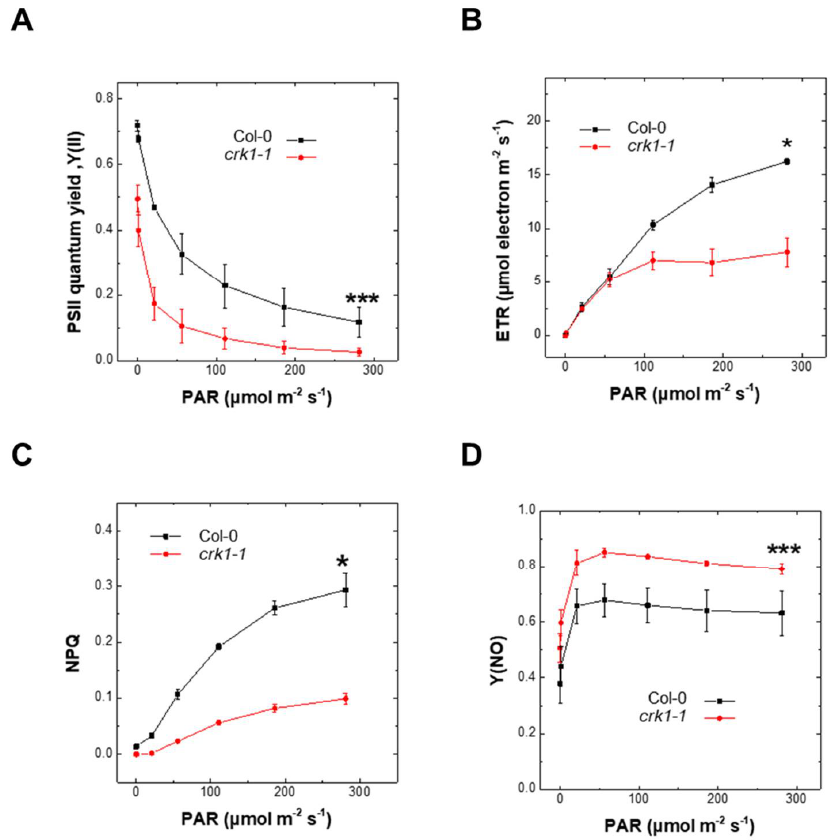
Figure 7. Photosynthetic parameters of At crk1-1 mutant under continuous light. ( A ) Effective PSII quantum yield ( Φ PSII ). The At crk1-1 mutant showed significantly lower effective PSII quantum yield values under all light intensities ( *** p ≤ 0.001); ( B ) Electron transport rate (ETR). The At crk1-1 mutant has significantly lower ETR values than wild type plants (* p ≤ 0.05); ( C ) Regulated Non- Photochemical Quenching (NPQ); ( D ) Non-regulated non-photochemical quenching (Y (NO)). The NPQ values of At crk1-1 plants were decreased (* p ≤ 0.05), while the Y (NO) showed increased (*** p ≤ 0.001)